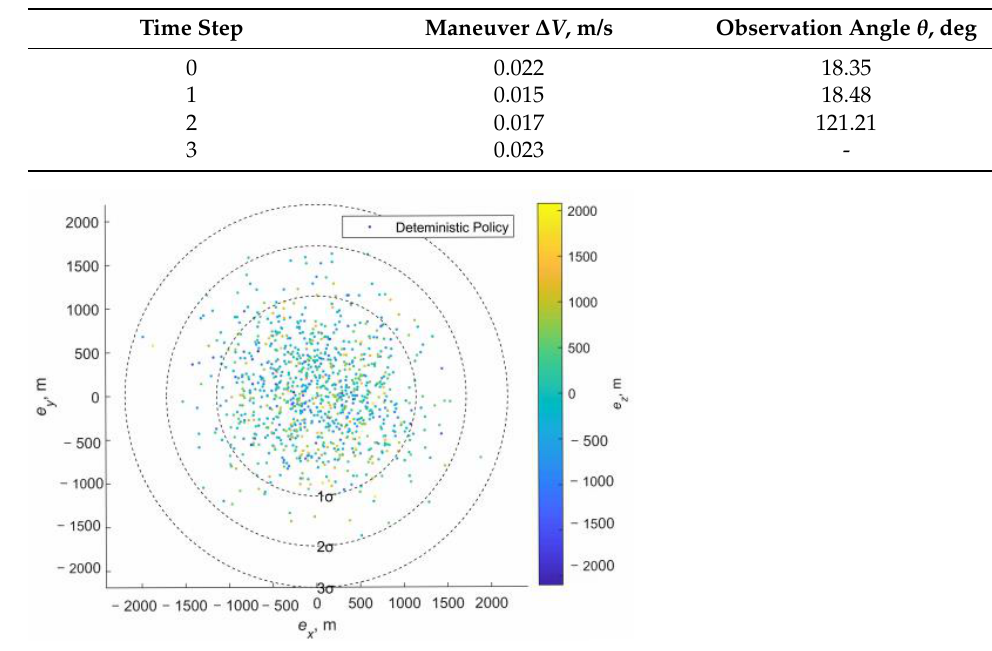
Figure 14. Distribution of the terminal position errors with deterministic guidance and the SaG strategy.